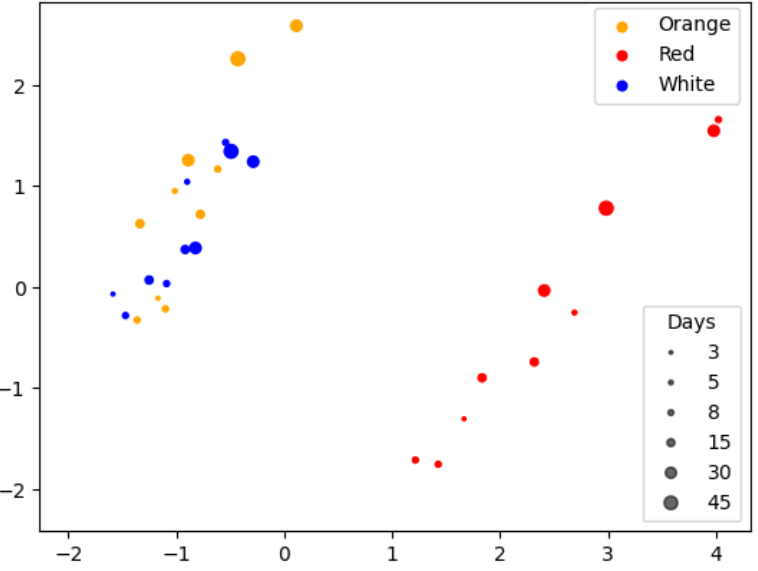
Figure 7. Principal components analysis (PCA) of Opuntia ficus-indica cv ‘Rossa’ (red juice) in red, cv ‘Gialla’ (orange juice) in orange, and cv ‘Bianca’ (white juice) in blue, for non-pasteurized samples and the two pasteurization methods (high-pressure processing and thermal pasteurization) showing the correlation between the different cultivars and the different physico-chemical and nutritional characteristics of Opuntia ficus-indica .